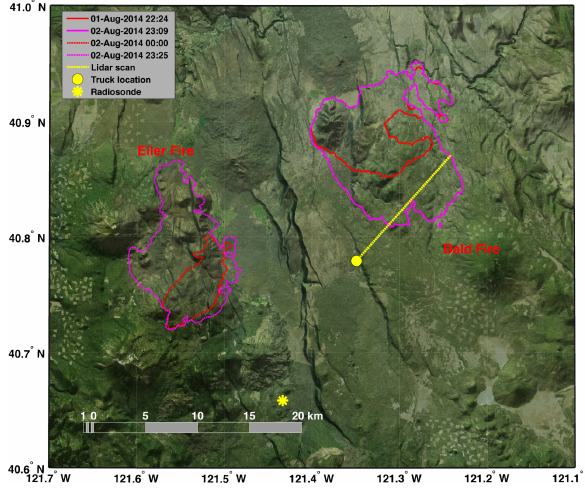
Figure 3. Bald and Eiler Fire progression map for 1 and 2 August. The fire perimeters are from the US National Forest Service Na- tional Infrared Operations (NIROPS) flights. The background is a satellite image draped over the terrain, which is highlighted with hill shading. Also shown are the truck location (yellow dot), lidar scan path (yellow line), and radiosonde location (yellow